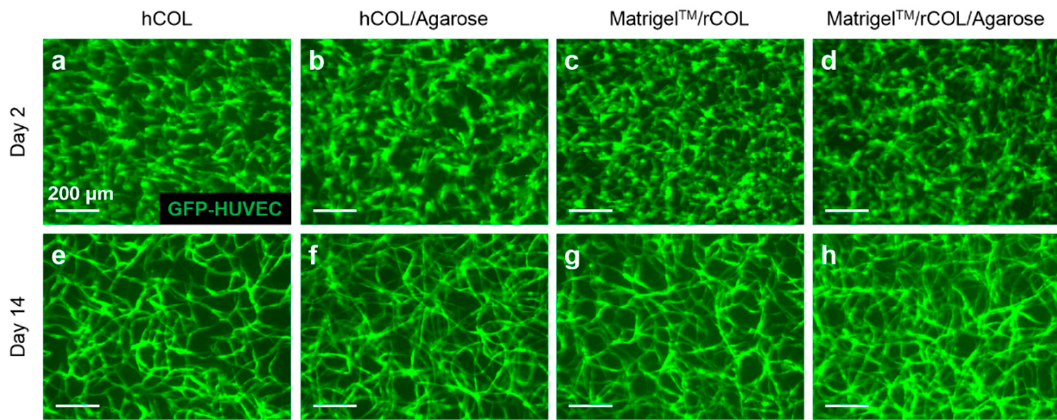
Figure 2. HUVECs self-assemble into an EC network when co-cultured with unlabeled-hASC in 3D hydrogel containing 0.03% SeaPlaque TM agarose. 3D hydrogel constructs containing GFP-HUVECs after 2 ( a – d ) and 14 days ( e – h ) of culture using hCOL ( a , e ), hCOL / Agarose ( b , f ), Matrigel TM / rCOL ( c , g ), Matrigel TM / rCOL / Agarose ( d , h ). EC network formation started at day 2 of cultivation in all hydrogel settings. The formed networks were stable during the cultivation period of 14 days. Scale bar: 200 μ m.